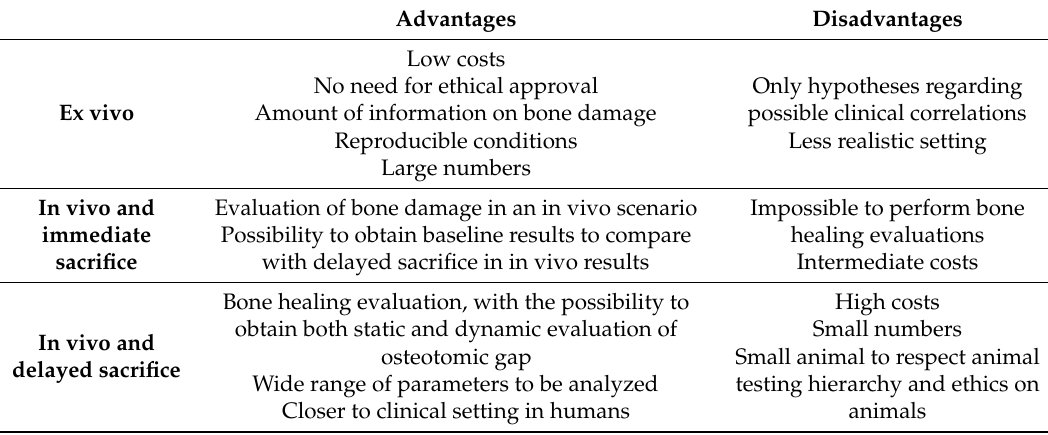
Table 3. Advantages and disadvantages according to di ff erent times of euthanasia in animal models.